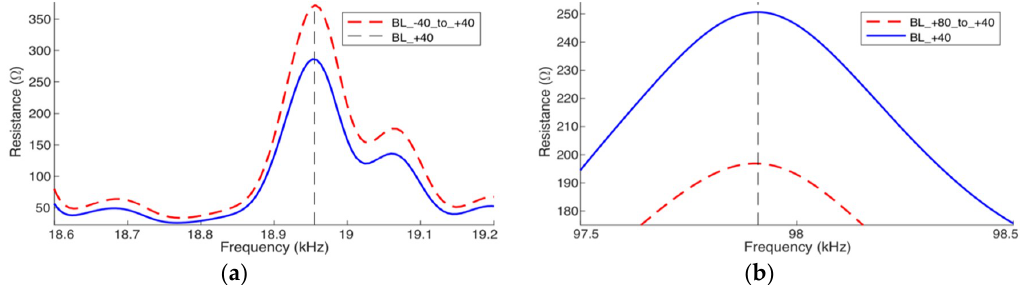
Figure 14. Horizontal compensation—Case 3 (Simulation) pipe-1/PZT-1: ( a ) at low frequency and ( b ) at high frequency.